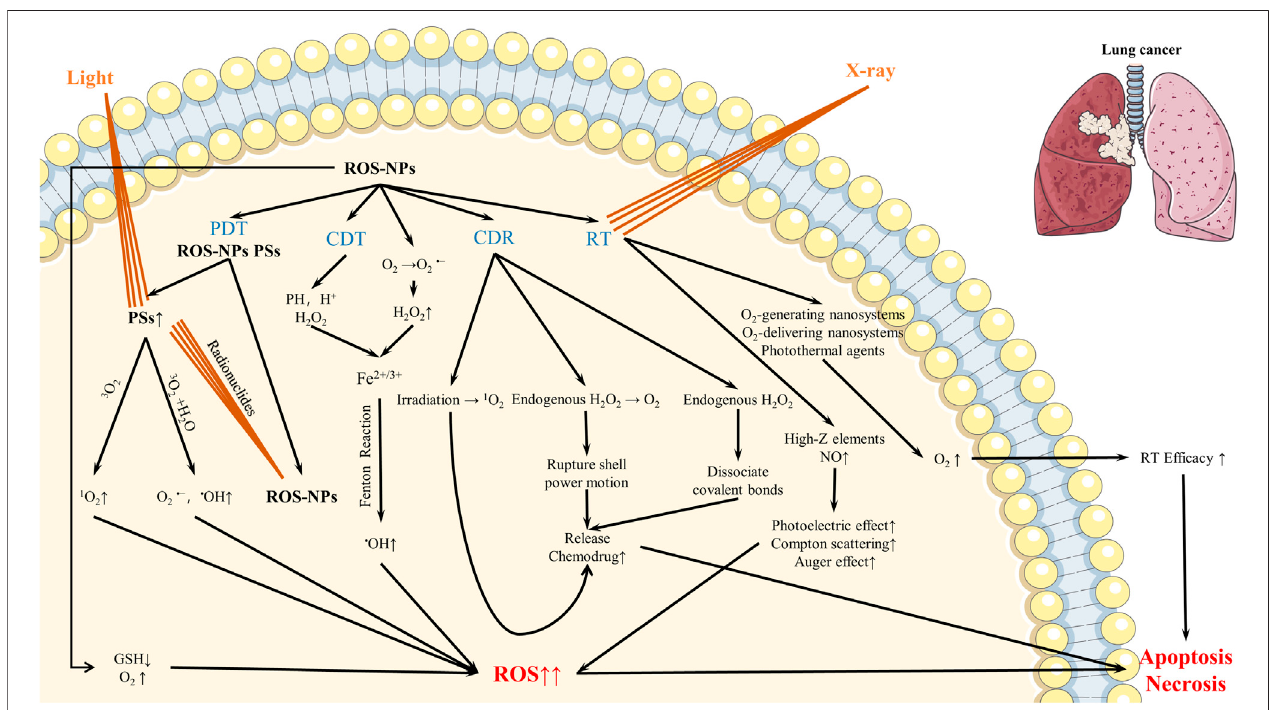
FIGURE 1 | Mechanism of ROS-based nanomaterials in lung cancer